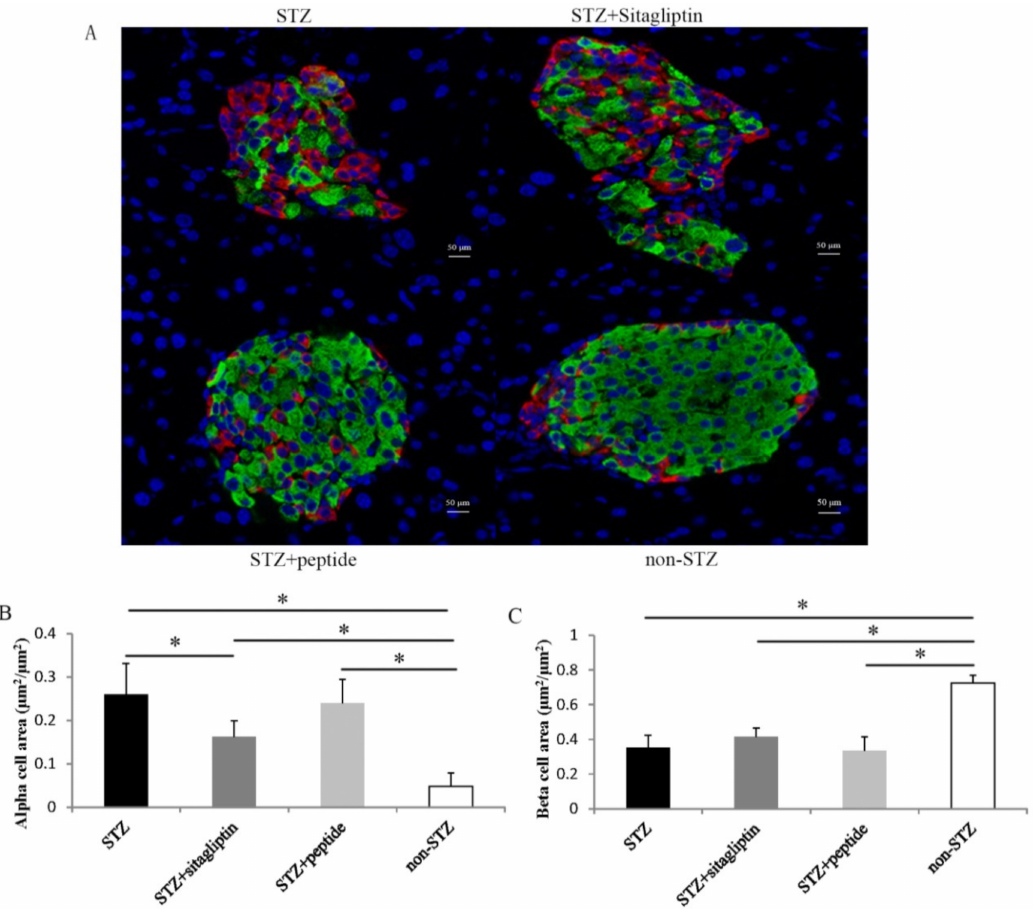
Figure 4. Immunochemical analysis was investigated at day 57. ( A ) Pancreatic sections were stained with insulin (green), glucagon (red), with representative islets shown (scalebars: 50 µ m; magnification: × 400). ( B ) Glucagon-positive (alpha) cell area per islet area. ( C ) Insulin-positive (beta) cell area per islet area. The data of the alpha and beta cell area are presented as means ± SE (Standard Error). Black columns show STZ control mice ( n = 9); the deep gray columns show the STZ mice administrated with sitagliptin ( n = 6); the light gray columns represent STZ mice administrated with synthetic peptide II ( n = 7); and the white columns show the normal control ( n = 10). Every islet executed three slices. Statistical significance: * p <